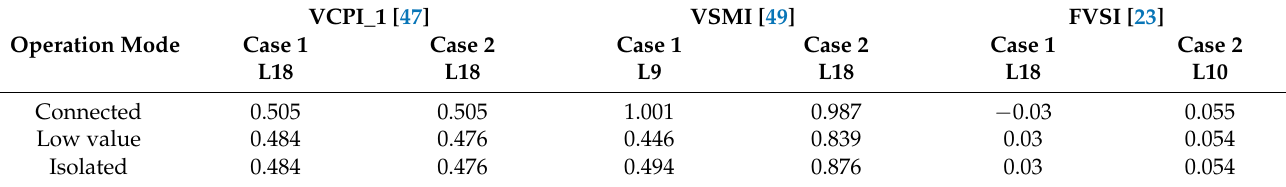
Table 5. Comparison of VSIs with frequency-dependent